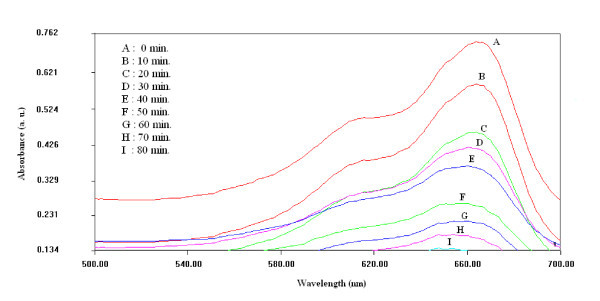
Absorption spectrum of dye solution for different durations of UV-radiation exposure in the presence of Zn0.9900Mn0.0100S nanocrystals.